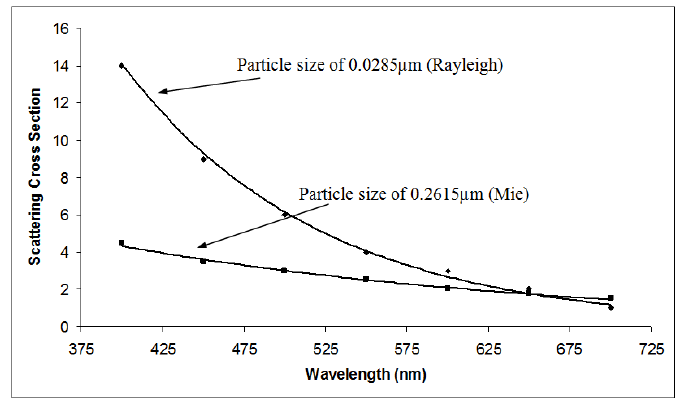
Figure 2. Rayleigh scattering and Mie scattering cross section vs wavelength for particle size of 0.0285 µm and 0.2615 µm, respectively